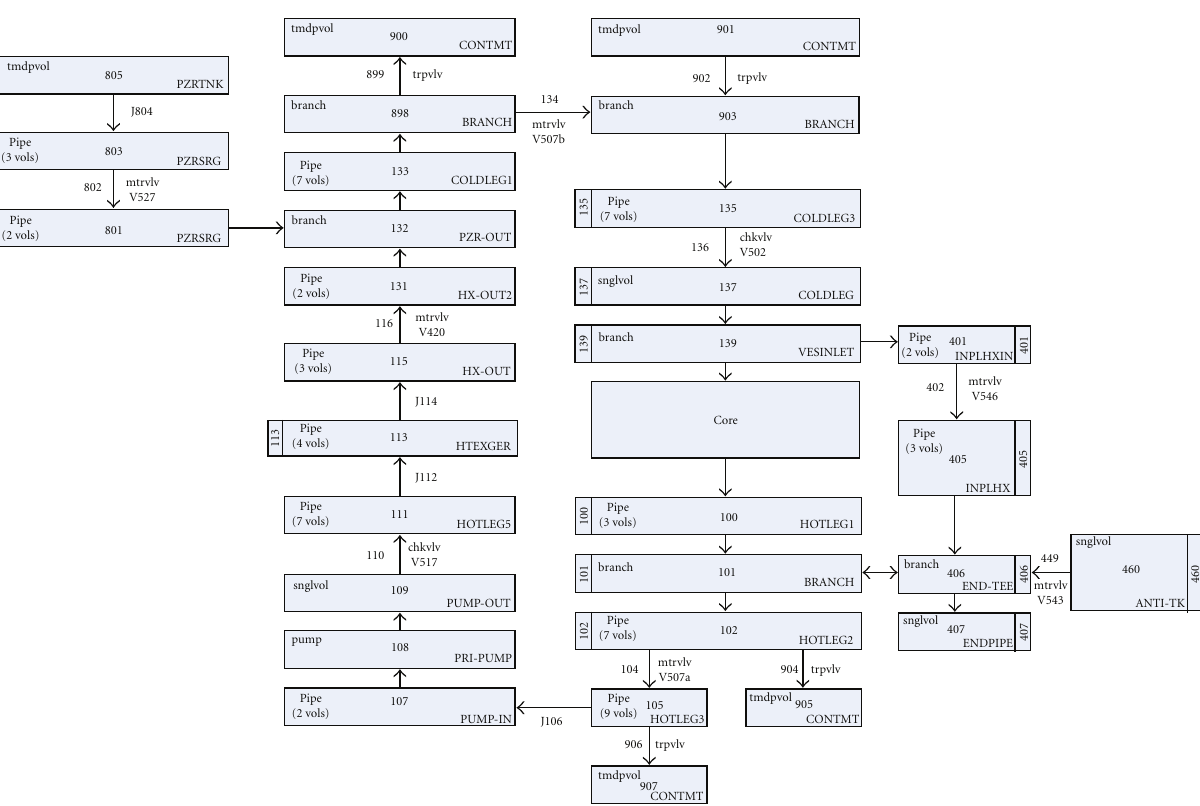
either forced or natural circulation, depending upon the